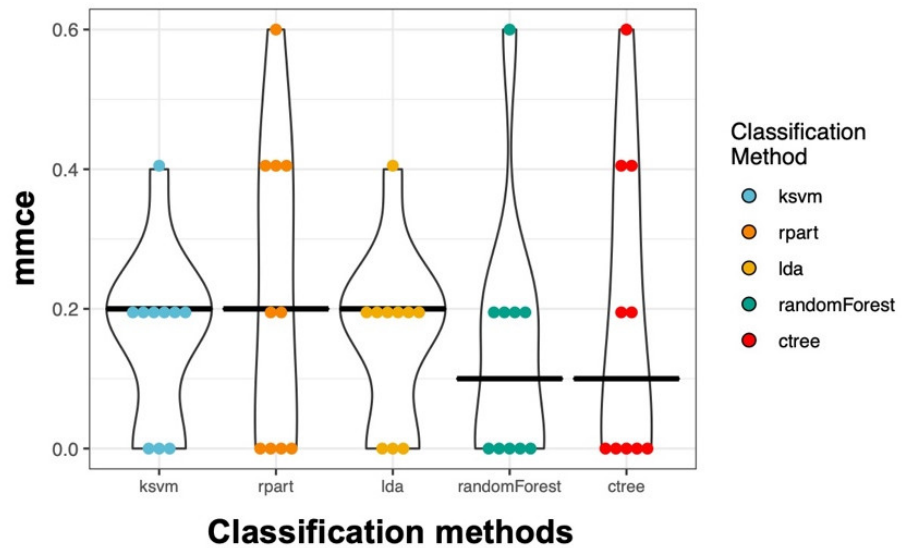
Figure 10. Mean misclassification errors for the five classification methods. The mean misclassification errors (mmce) for the five classification methods and 23 predictor variables (kvsm: Support Vector Machines, rpart: Decision Tree, lda: Linear Discriminant Analysis, randomForest: Random Forest, ctree: Conditional Inference Trees) are depicted as violin plots for all resampling iterations. Resampling strategy: 10-fold cross-validation. Each point represents an iteration.